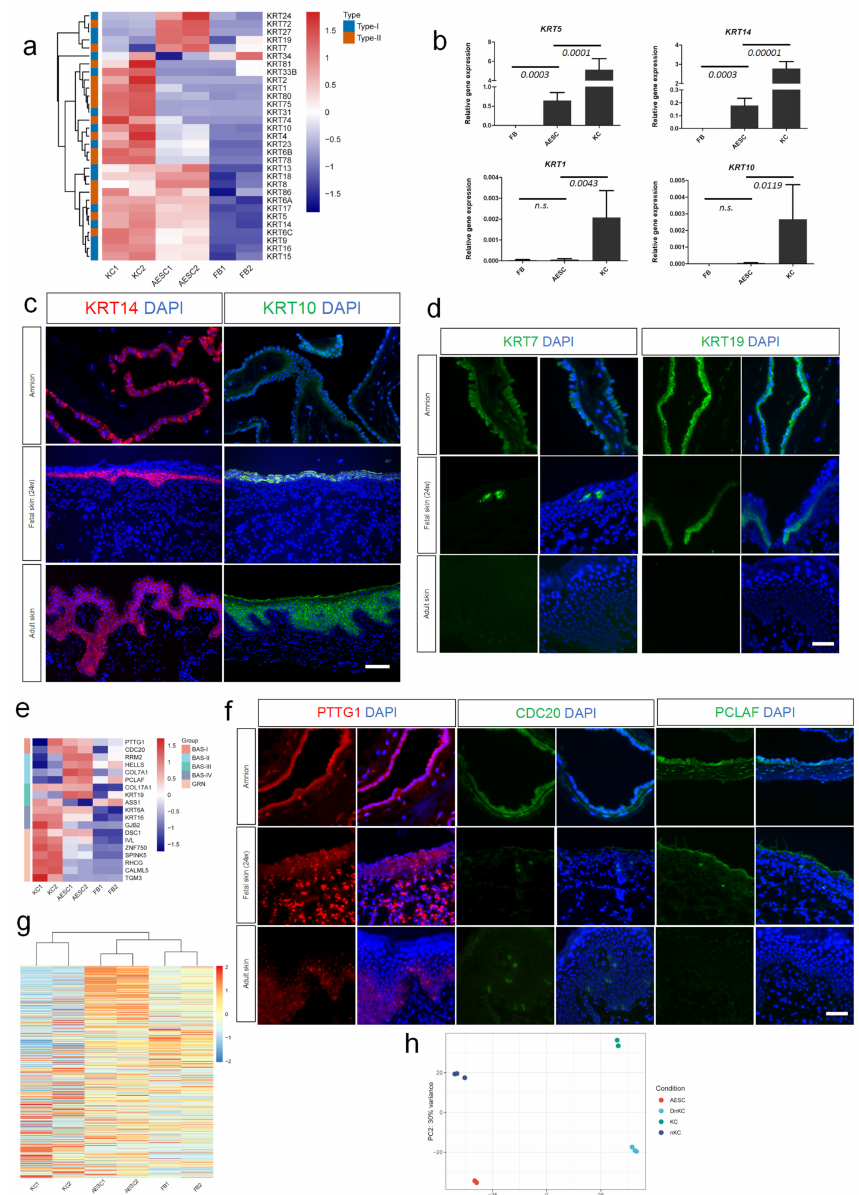
Figure 2. Similarity of amniotic epithelial stem cells (AESCs) to early stage immature keratinocytes (KCs). ( a ) Heatmap of keratin family genes revealed specific and distinct patterns in AESCs and KCs. ( b ) Expression of undifferentiated ( KRT5 & KRT14 ) and differentiation ( KRT1 & KRT10 ) genes in AESCs detected by qRT-PCR. ( c ) KRT14 and KRT10 immunostaining in the amnion, fetal skin (at 24 weeks gestation) and adult foreskin. ( d ) KRT7 and KRT19 immunostaining in the amnion, fetal skin (at 24 weeks gestation) and adult foreskin. ( e ) Heatmap reveals that critical markers of early stage KCs were highly expressed in AESCs. ( f ) PTTG1, CDC20, and PCLAF immunostaining in the amnion, fetal skin (at 24 weeks gestation) and adult foreskin. ( g ) Heatmap of pseudotime-dependent genes involved in keratinocyte differentiation (Wang et al. [22]) shows that genes enriched in early stage KCs were highly expressed in AESCs (top to bottom corresponds to early stage to late stage). ( h ) Principal component analysis indicated that AESCs were closer to undifferentiated neonatal KCs (nKC). FB, fibroblast; AESC, amnion epithelial stem cell; KC, (adult) keratinocyte; nKC, neonatal KC; DnKC, differentiated neonatal KC (induced by adding 1.2 mM CaCl 2 ) [23]. Bars represent relative values (mean ± SD) calculated from at least three independent experiments. Student’s t test was used to calculate p values. Scale bar = 100 µ m ( c ); 50 µ m ( d , f